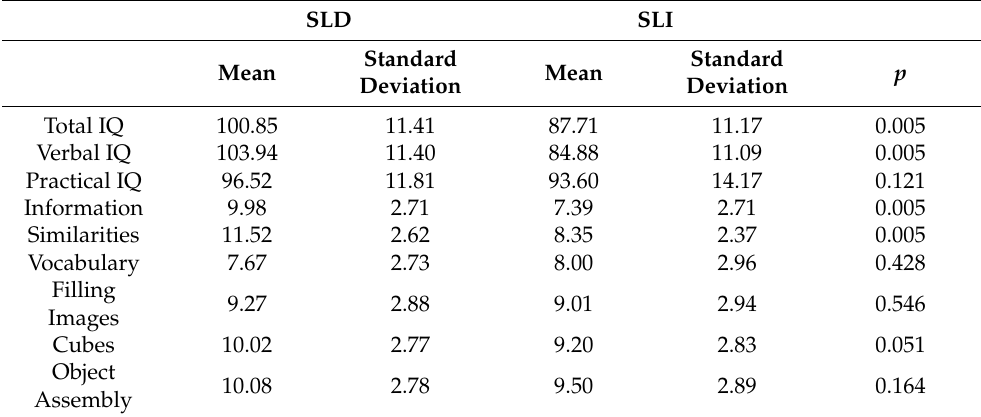
Table 2. Descriptive statistics for IQ with respect to diagnosis and significance of t